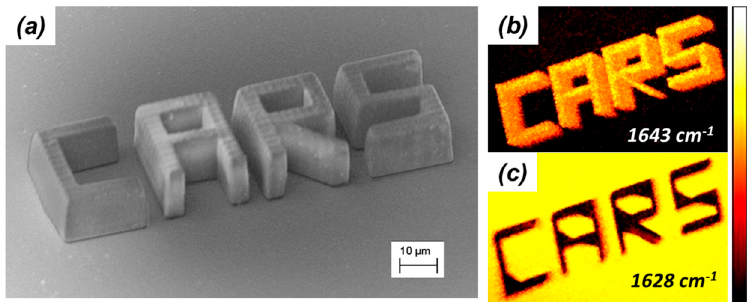
Figure 13. Comparison of CARS images of a TPP microstructure still immersed in the unpolymerized resin recorded at ( b ) 1643 cm − 1 and ( c ) 1628 cm − 1 . ( a ) SEM image of the tested microstructure performed after CARS imaging (scale bar 10 µm). The relative strengths between the resin polymerized microstructure get inverted when switching probing wavenumber. Reproduced from [57].